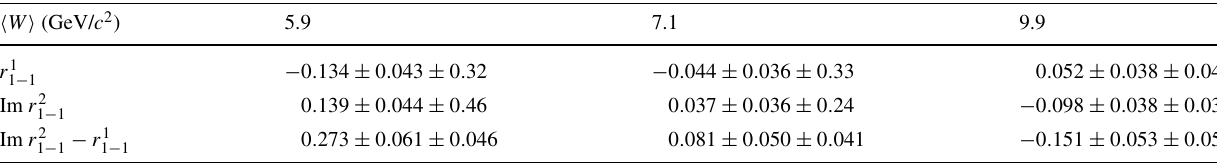
, Im r 2 and their 1 − 1 1 − 1